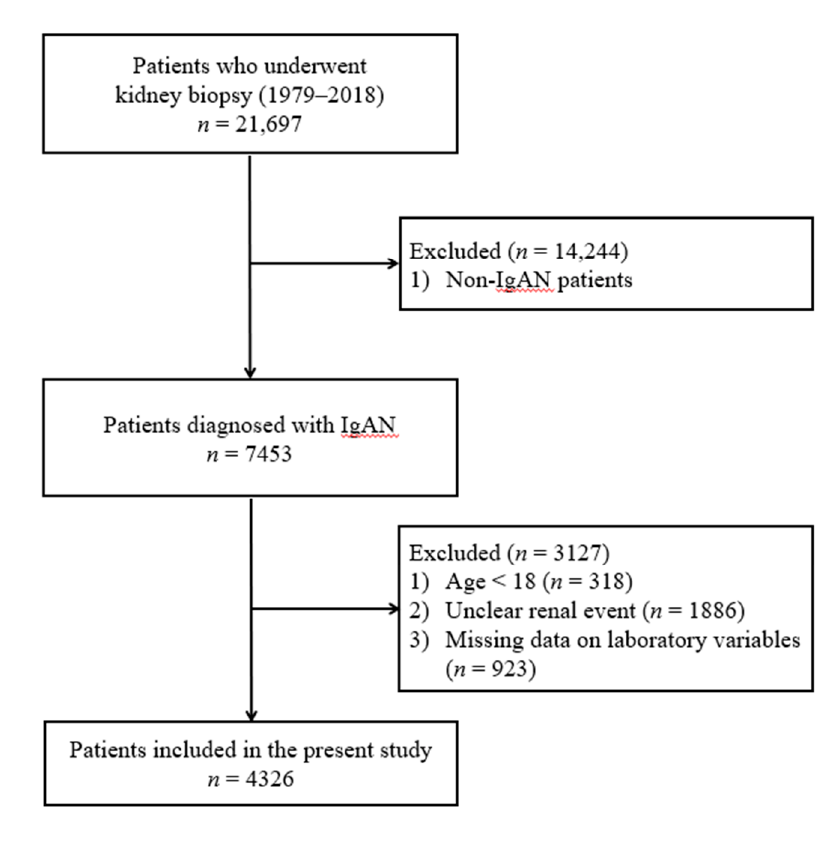
Figure 1. Enrollment of patients into this study.